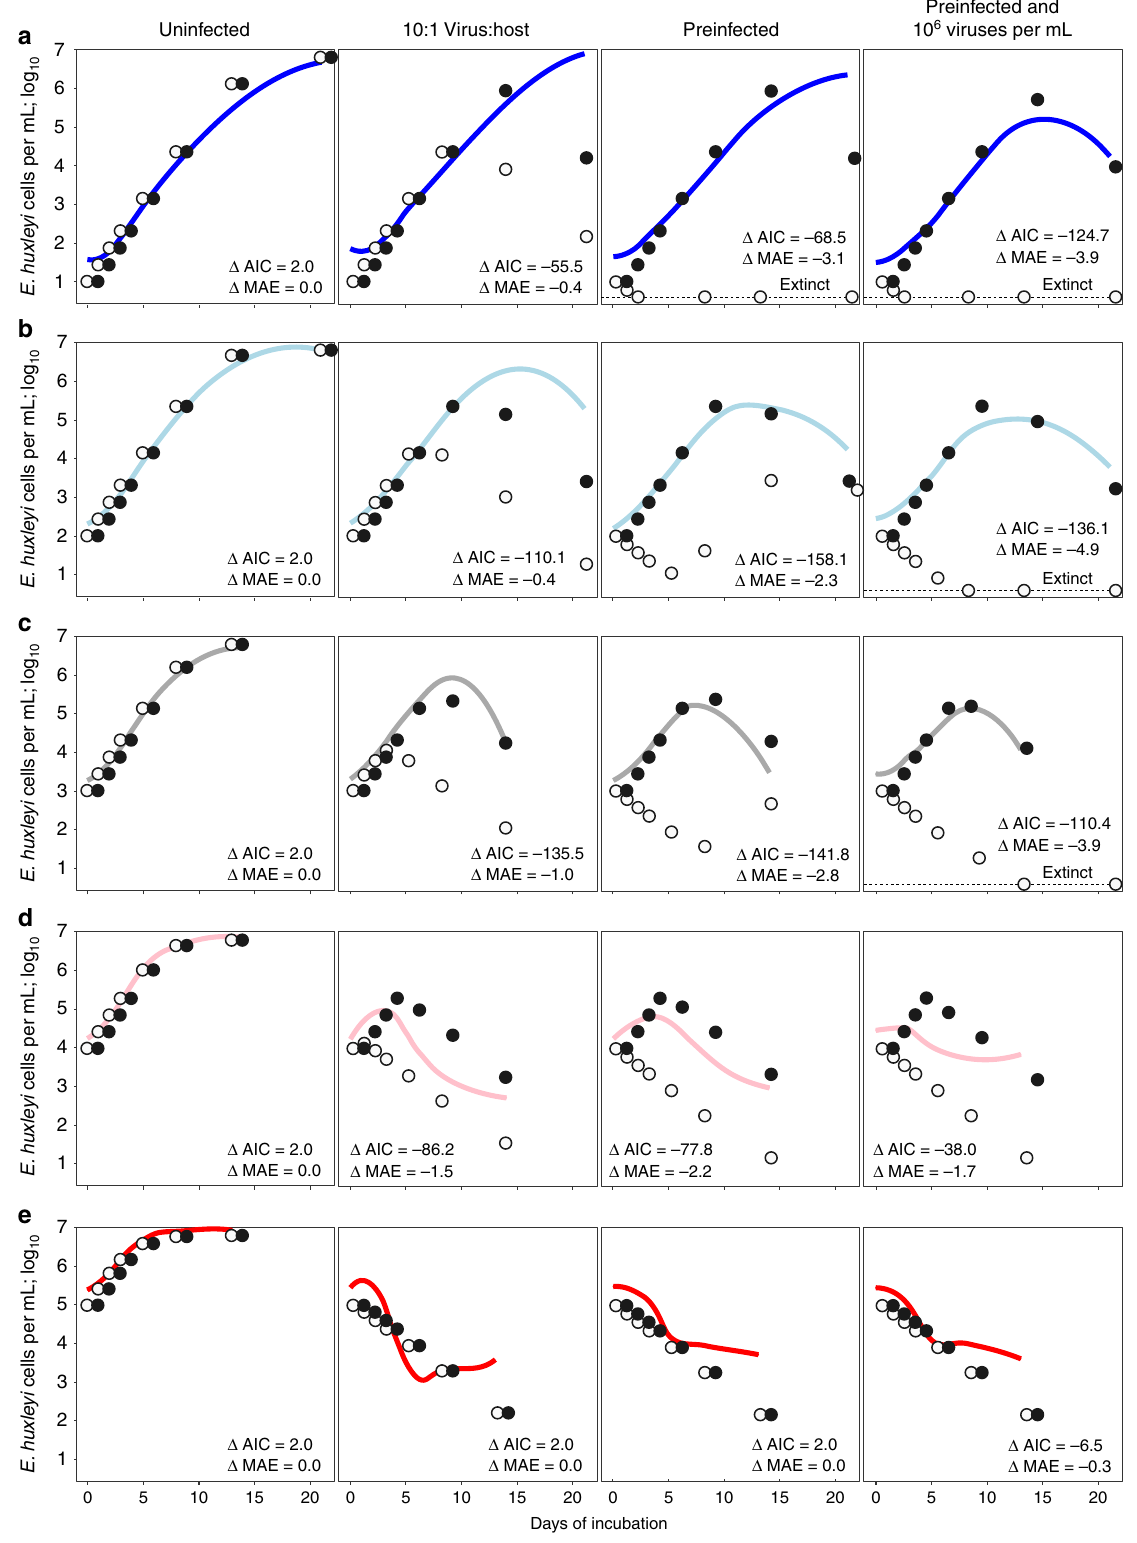
temperate model across all treatments and initial densities, but not by the virulence model, further providing further evidence of temperate infection (Fig. 3 and Supplementary Fig. 2; negative differences in akaike information criterion and mean absolute error values between models — Δ AIC and Δ MAE, respectively —